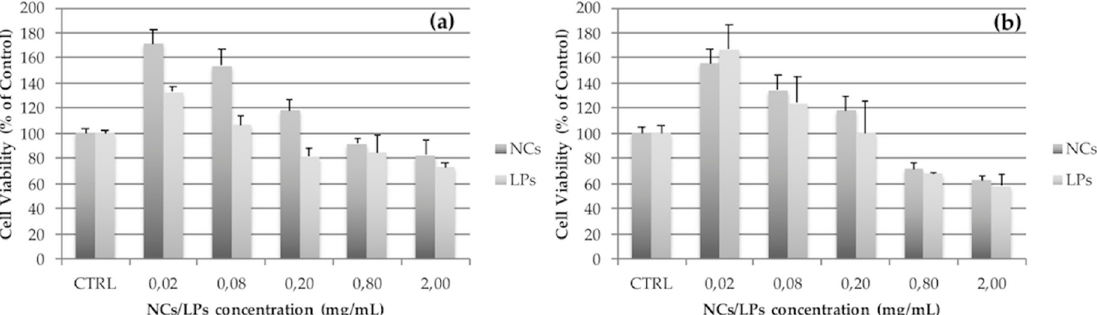
Figure 7. Cell viability after 24 h of exposition to NCs or LPs. The concentrations are expressed in mg/mL. The data represent the percentage of control ± SD. The J774a.1 ( a ) is a monocytes / macrophages cell line; the 3T3 ( b ) is a fibroblasts cell line.